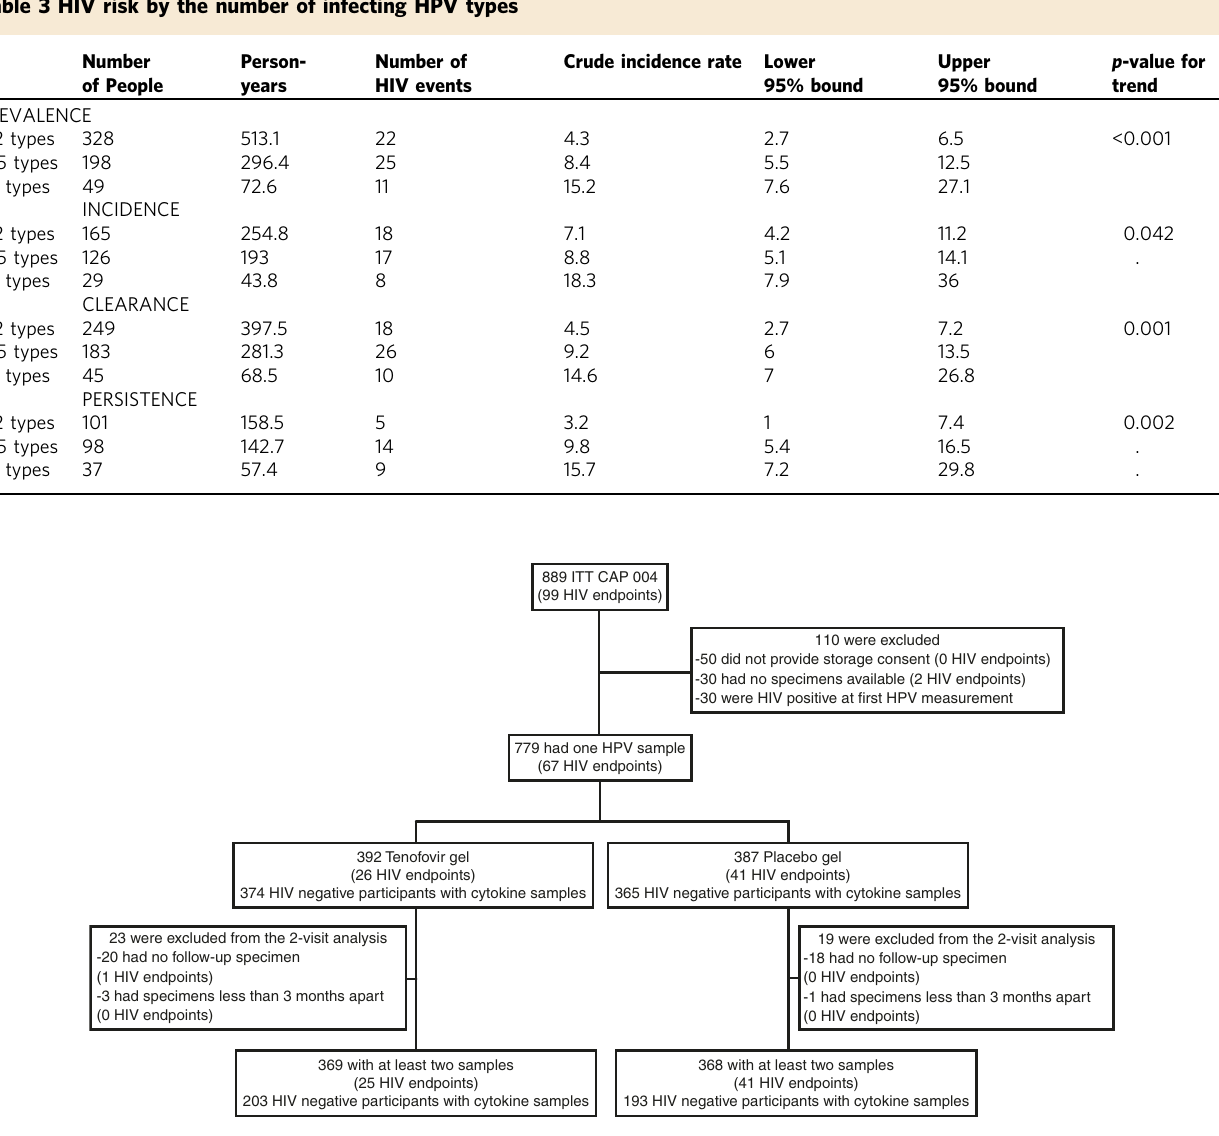
represents true elimination or latent HPV infection 38 . Similarly,